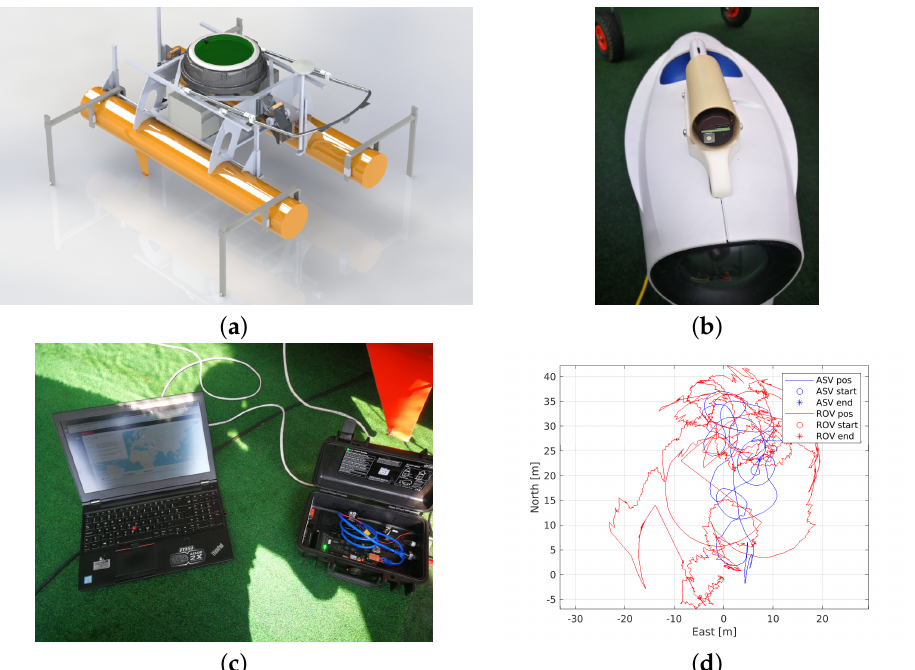
Figure 14. ( a ) The U1 locator is mounted on a bracket on top of the Blueye Pro ROV. The cap is open to show the USB-C charging port and the rotary switch for channel selection. ( b ) Calibration of the topside IMU. ( c ) Relative positions of the ROV merged with the ASV heading in the local NED frame. ( d ) Georeferenced positions of the